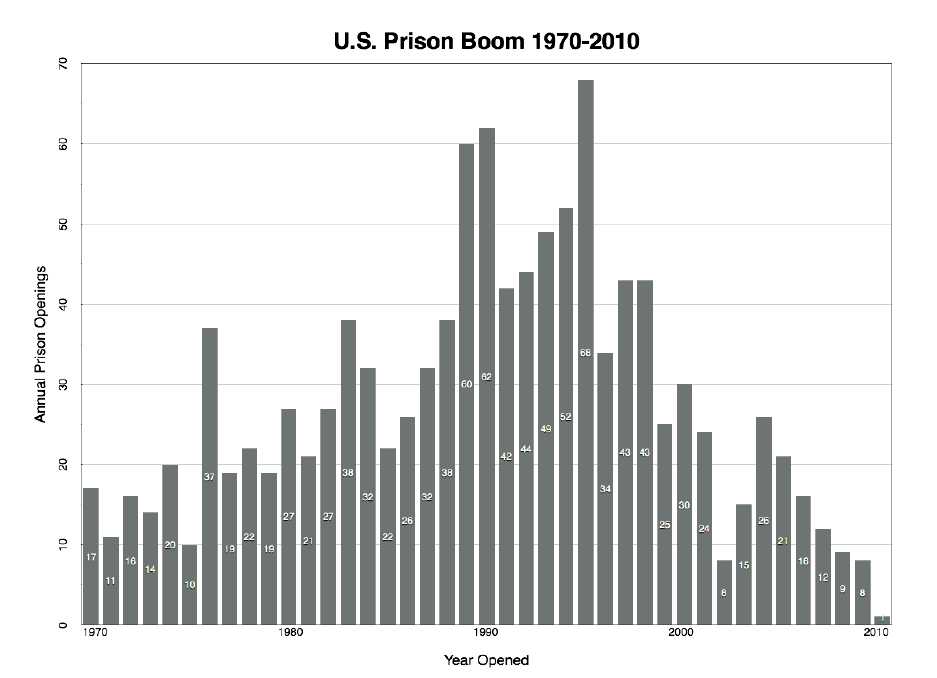
Figure 2. U.S. prison-building, 1970–2010. Source: Prison Proliferation Project.